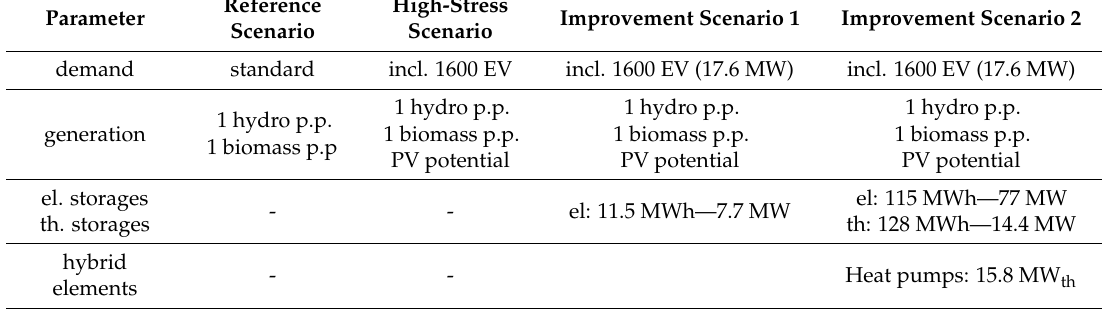
Table 4. Configuration levels for case study 2.